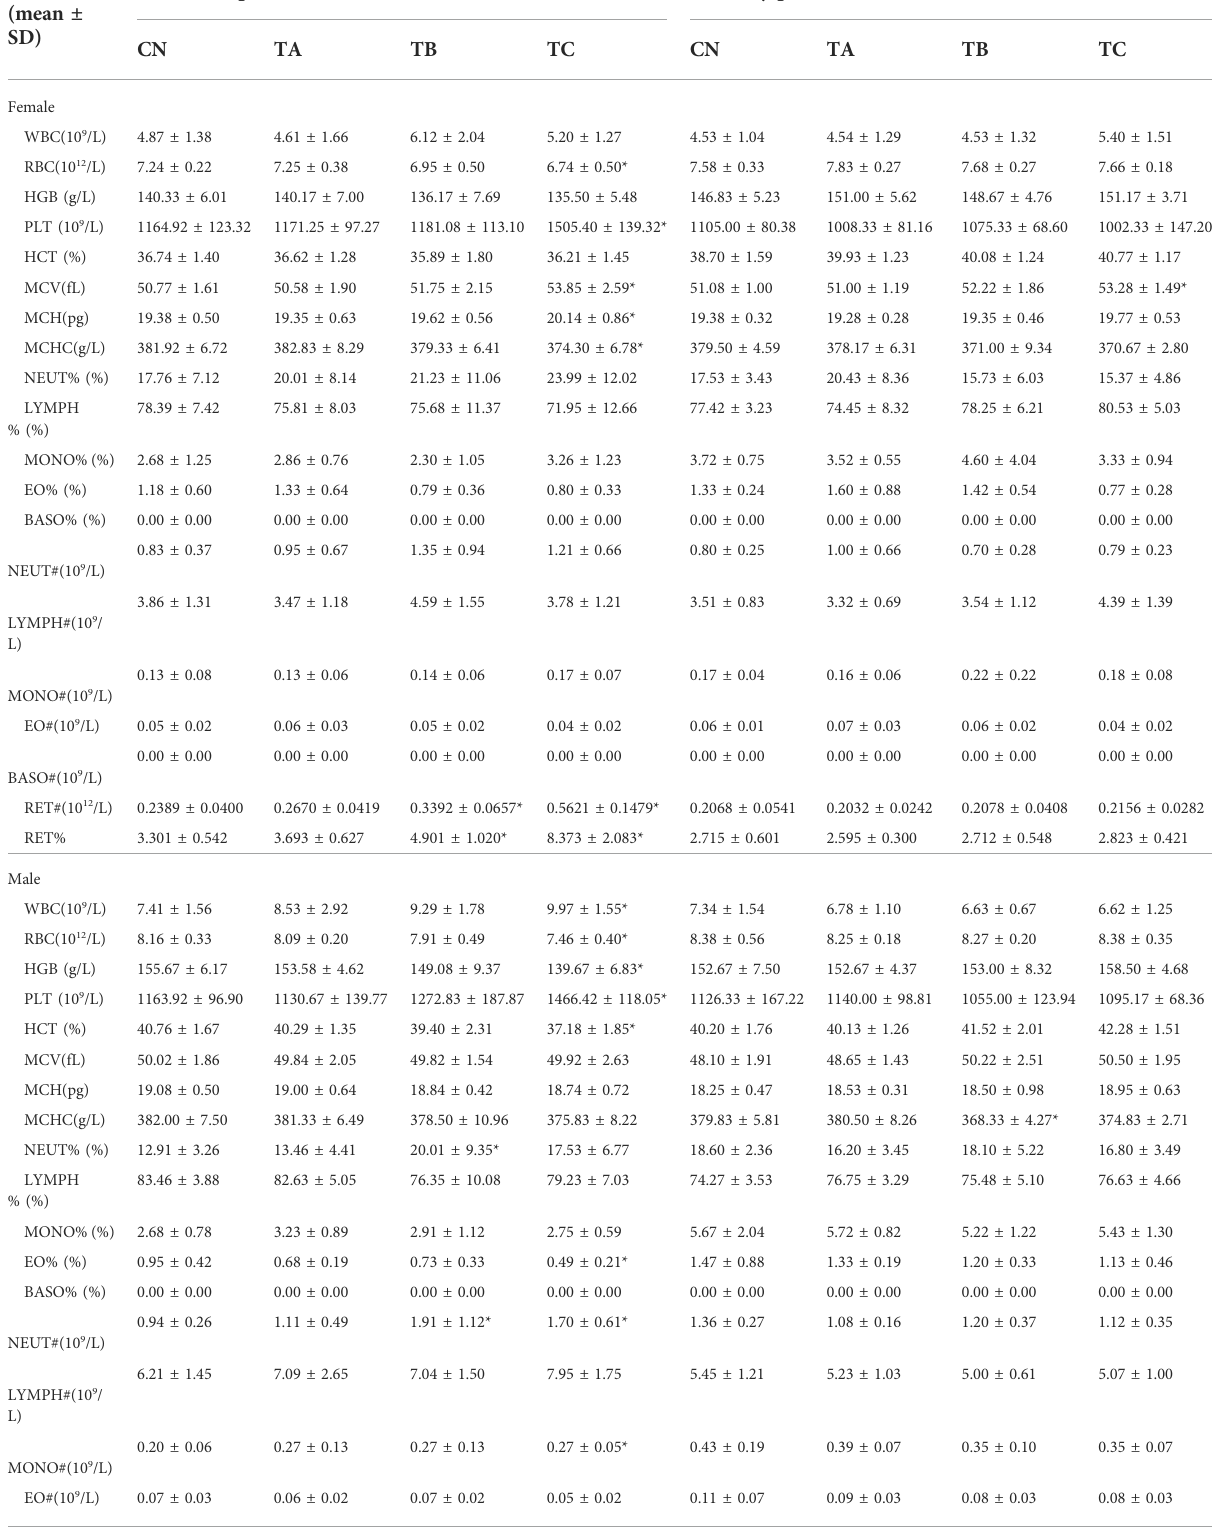
TABLE 2 Effect of QZZD on hematological parameters in the sub-chronic oral toxicity